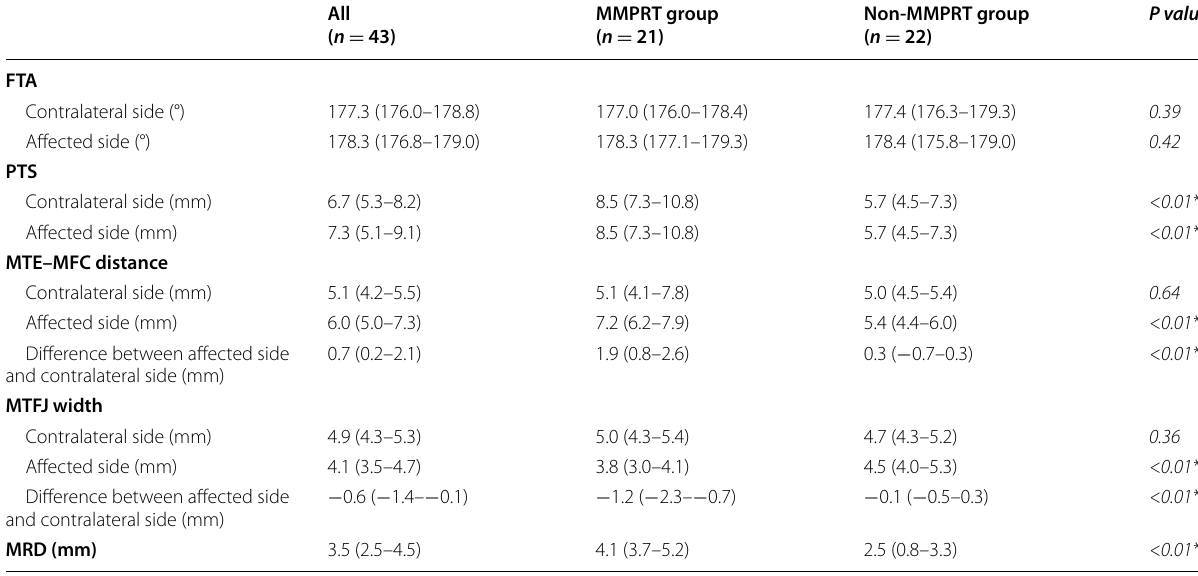
Table 2 Comparison of X-ray and MRI measurements between patients in the MMPRT group and non-MMPRT group